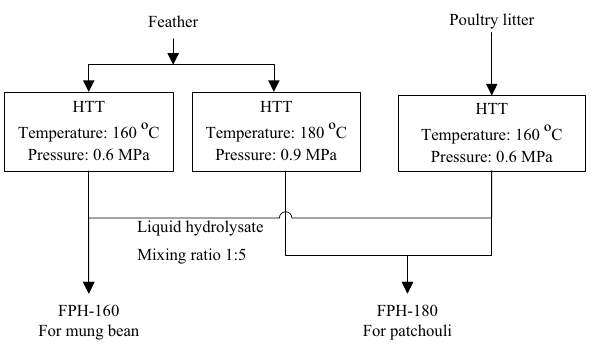
Fig. 1 The experimental scheme of FPH